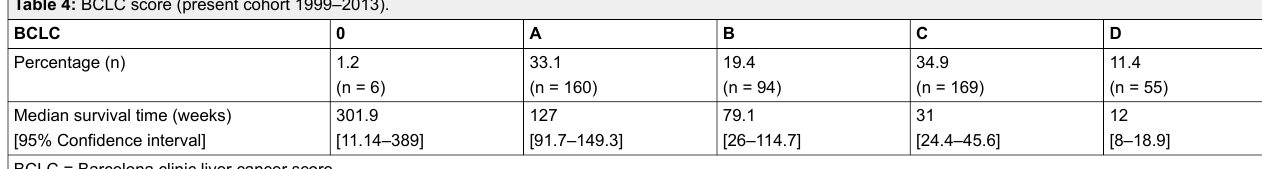
Table 4: BCLC score (present cohort 1999–2013).